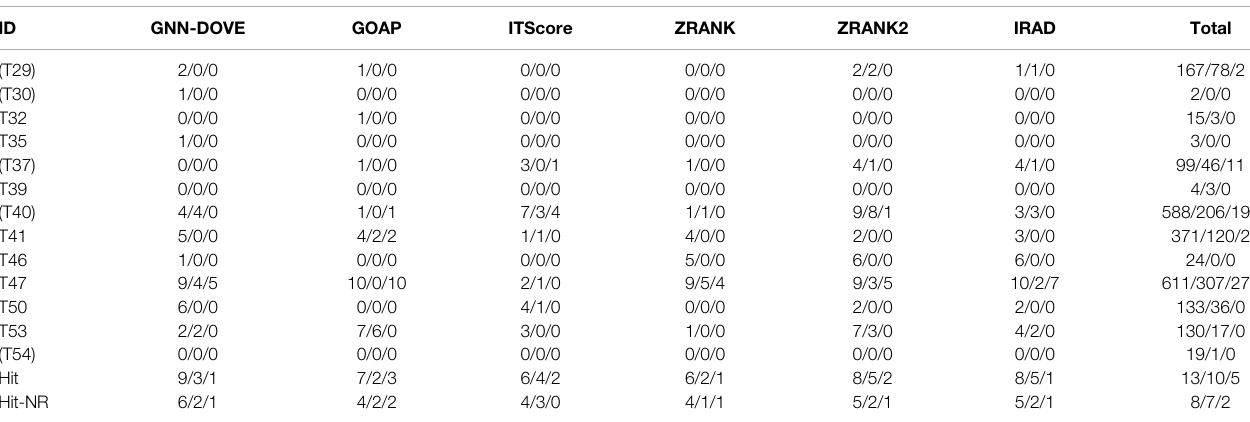
TABLE 4 | Performance on the CAPRI scoring